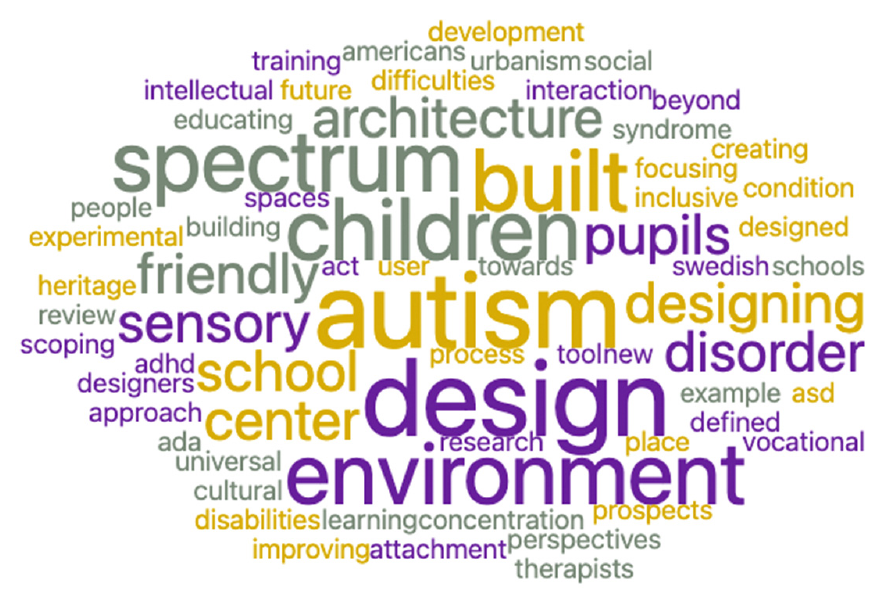
Figure 6. Word cloud distribution of experts’ documents.